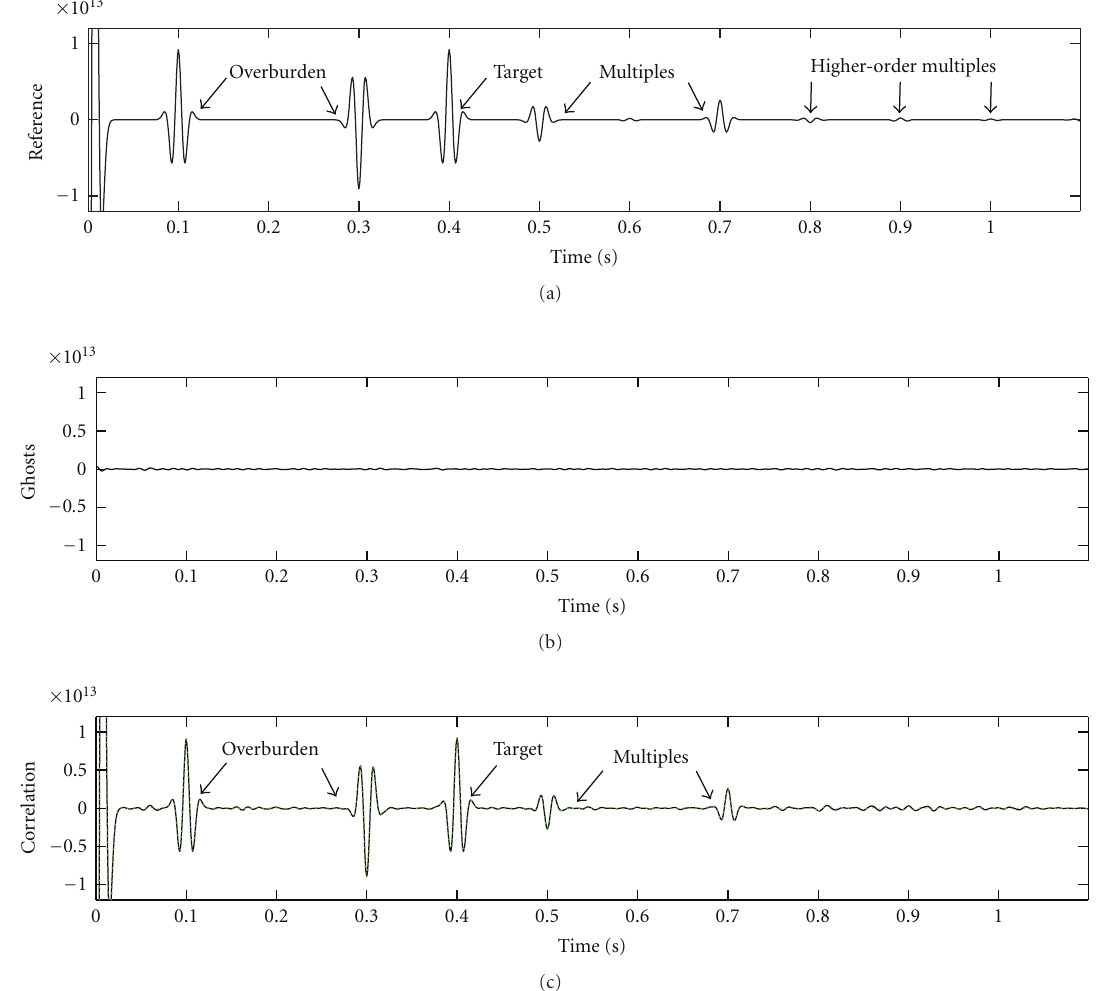
Figure 6: Cross-correlation of full fields for model C: (a) reference response by placing an active source at the virtual source location x A ; (b) computed ghost terms g S + g O ; (c) causal part of the correlation function C (black) and the sum of reference response + ghosts (dashed